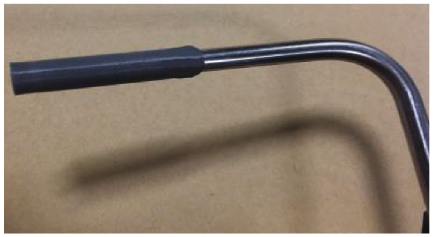
Figure 8: Rubber sleeve blocking the pitot tube. Table 4: Experimental parameters of non-ice material blockage.